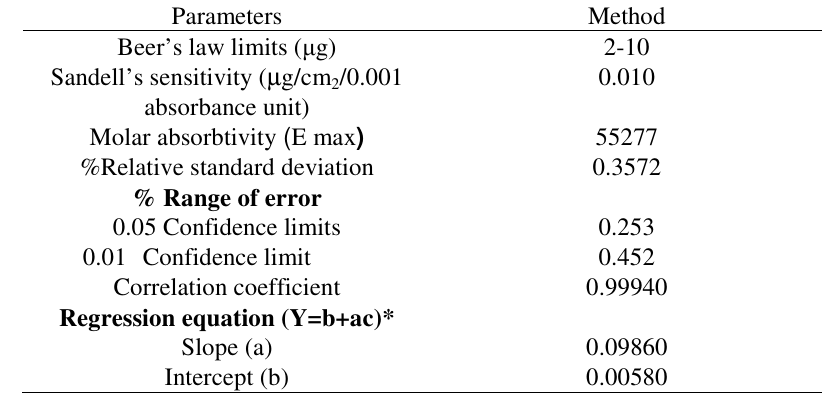
Figure 1 . The accuracy of the method was ascertained by comparing the results of the proposed methods with that of reported method (Table 2). Table 1. Optical characteristics